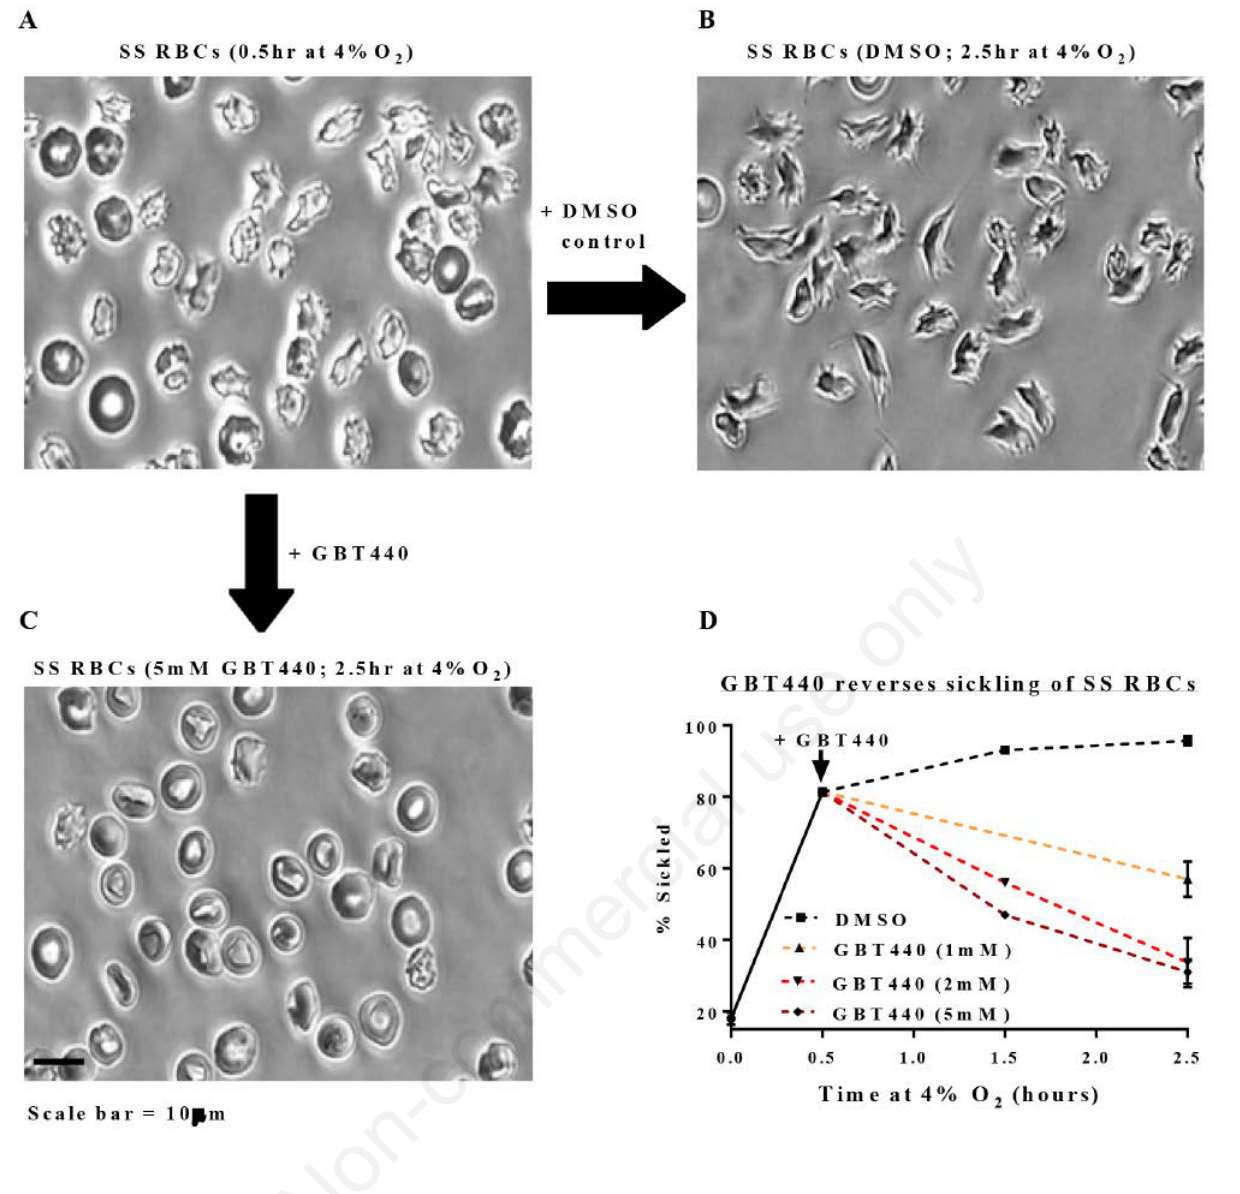
Figure 3. GBT440 reverses sickling of sickled SS RBCs. (A) Representative image of sickled SS RBCs at 4% O2 for 0.5 hours. (B) Representative image of sickled SS RBCs in (A) treated with DMSO (control) at 4% O2 for an additional 2 hours. (C) Representative image of sickled SS RBCs in (A) treated with GBT440 (5 mM) at 4% O2 for an additional 2 hours. Solid black line represents the scale of the images in (A), (B) and (C). (D) Graph showing quantification of sickled SS RBCs treated with GBT440 or control in (A), (B) and